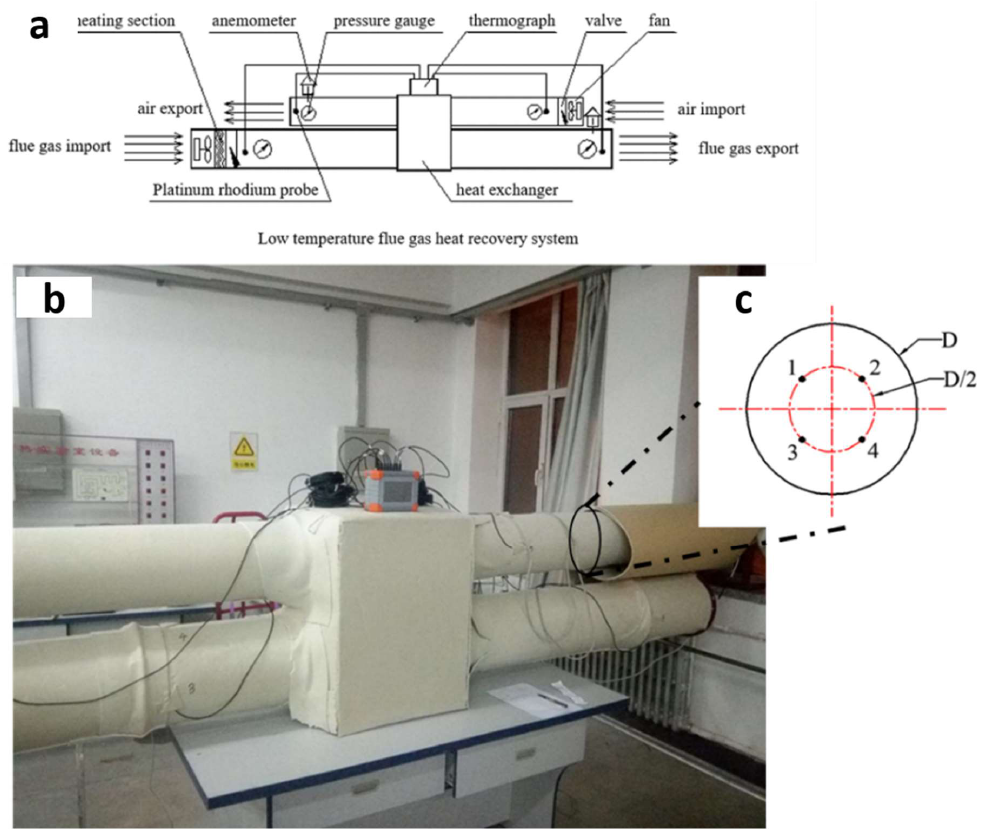
Figure 3. ( a ) Micro heat pipe low-temperature flue gas heat recovery system; ( b ) Experimental test of low-temperature flue gas heat recovery unit of the micro heat pipe Layout for wind speed measurement; ( c ) Layout for wind speed